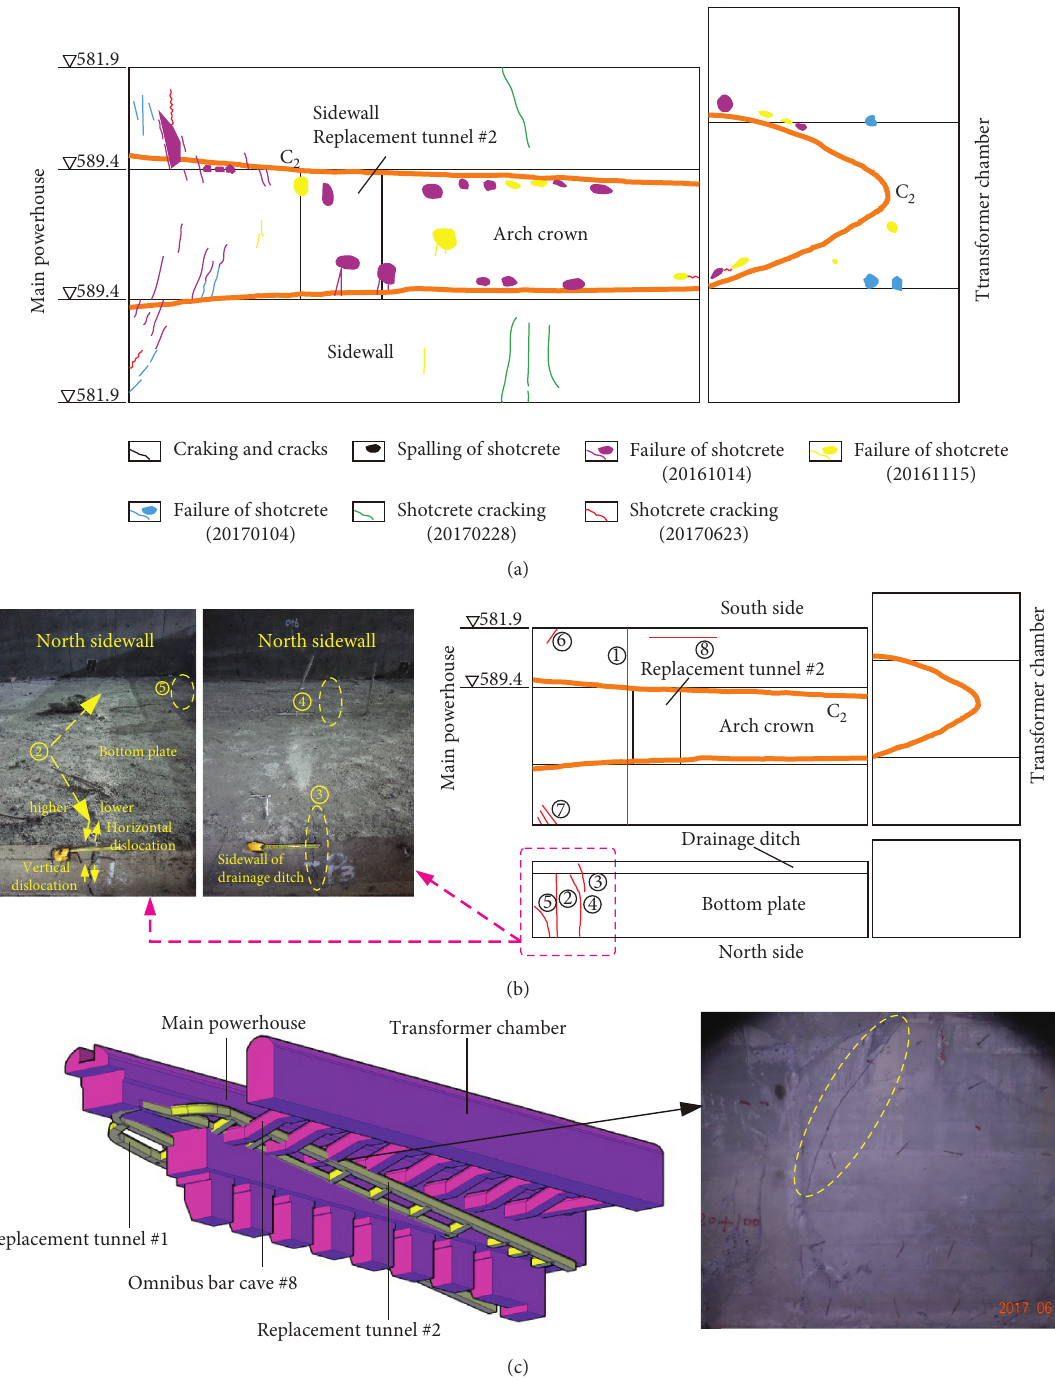
Figure 8: Failure in omnibus bar caves and replacement tunnel #2: (a) distribution diagram of failure of shotcrete in omnibus bar cave #8; (b) distribution of cracks in the lining concrete of omnibus bar cave #8; (c) cracking in the backfill concrete of replacement tunnel